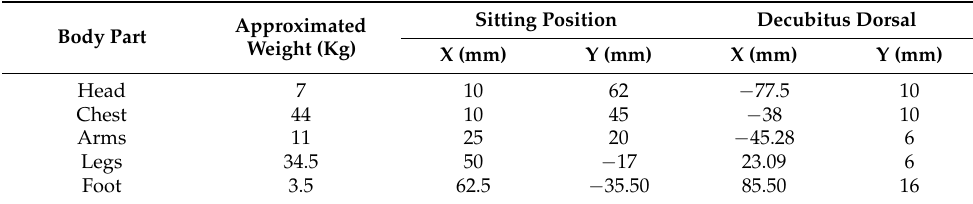
Table 4. Geometrical values of body